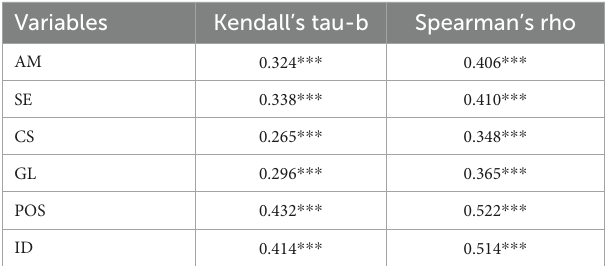
TABLE 5 Correlation analysis of intrinsic drive and turnover